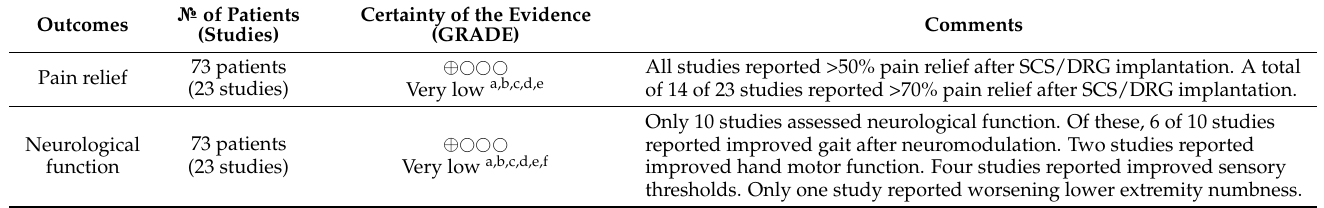
Table 3. Summary of Findings Table. Per the Grading of Recommendations, Assessment, Develop- evidence for each outcome of interest. Population: Cancer patients with CIPN. Intervention: SCS, DRG-S, and/or PNS trial/implant. Comparison: baseline pain/neurological